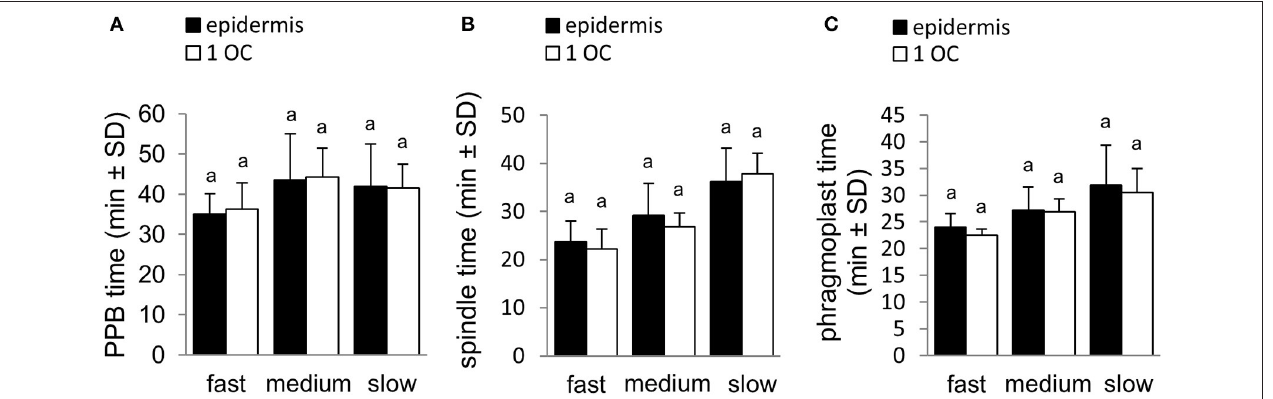
FIGURE 2 | Comparison of duration time of individual cell division stages between epidermis and first outer cortex (1 OC) cell layer. (A) Average PPB stage duration in the preprophase and prophase stages of cell division in epidermis and first outer cortex for fast-growing, medium-growing and slow-growing roots. (B) Average mitotic spindle stage duration from prometaphase to telophase during cell division in epidermis and first outer cortex for fast-growing, medium-growing and slow-growing roots. (C) Average phragmoplast stage duration in cytokinesis of the cell division in epidermis and first outer cortex for fast-growing, medium-growing and slow-growing roots. Letters above the bars represent statistical significance according to one-way ANOVA test at P < 0.05.